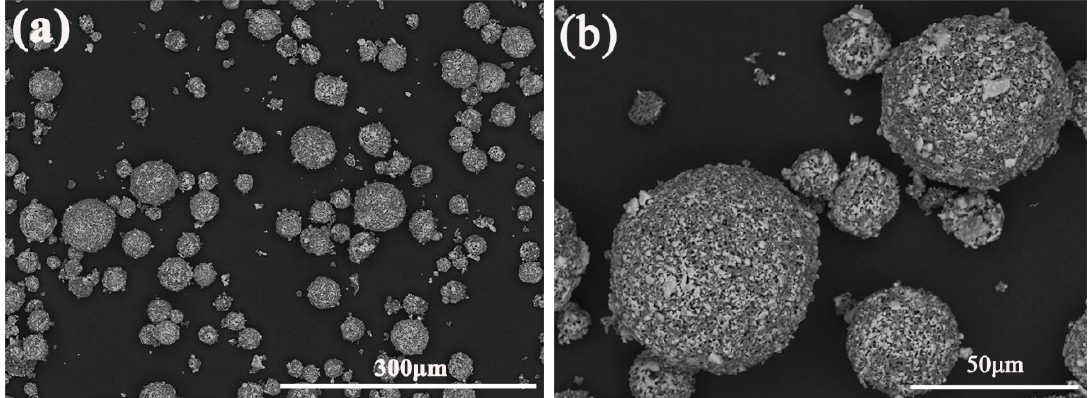
Figure 8. The morphology of powders after process optimization. ( a ) ×300; ( b ) ×1500.